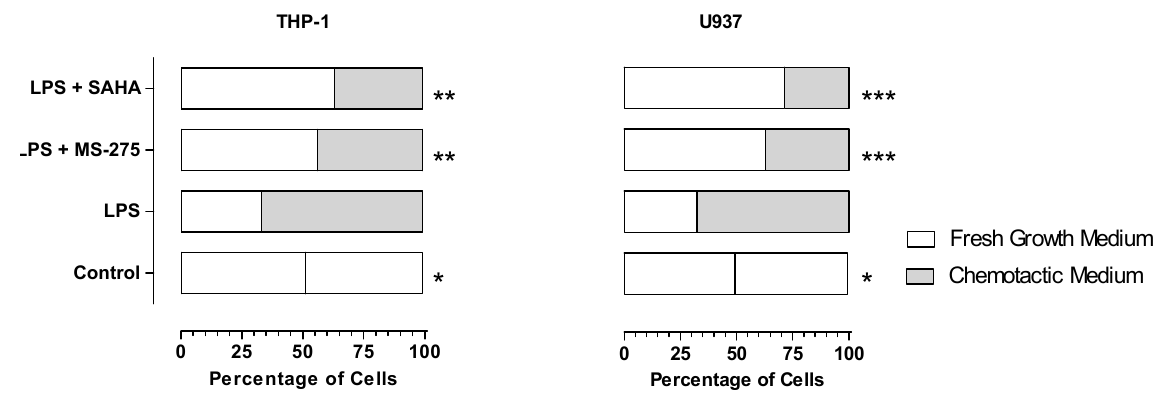
Figure 3. MS-275 and SAHA inhibited E11-driven migration of THP-1 and U937 cells. Number of cells migrated into fresh growth medium and chemotactic medium (in which E11 cells were grown in the presence or absence of LPS (5 μ g/mL) and HDAC inhibitors (100 nM) for 24 h) were counted under a light microscope. The distribution profiles for the control and various treatment groups were expressed in percentages and depicted in a bar chart. * = p < 0.05, ** = p < 0.01, *** = p <0.001 (between this group and LPS group, two-tailed Chi-square